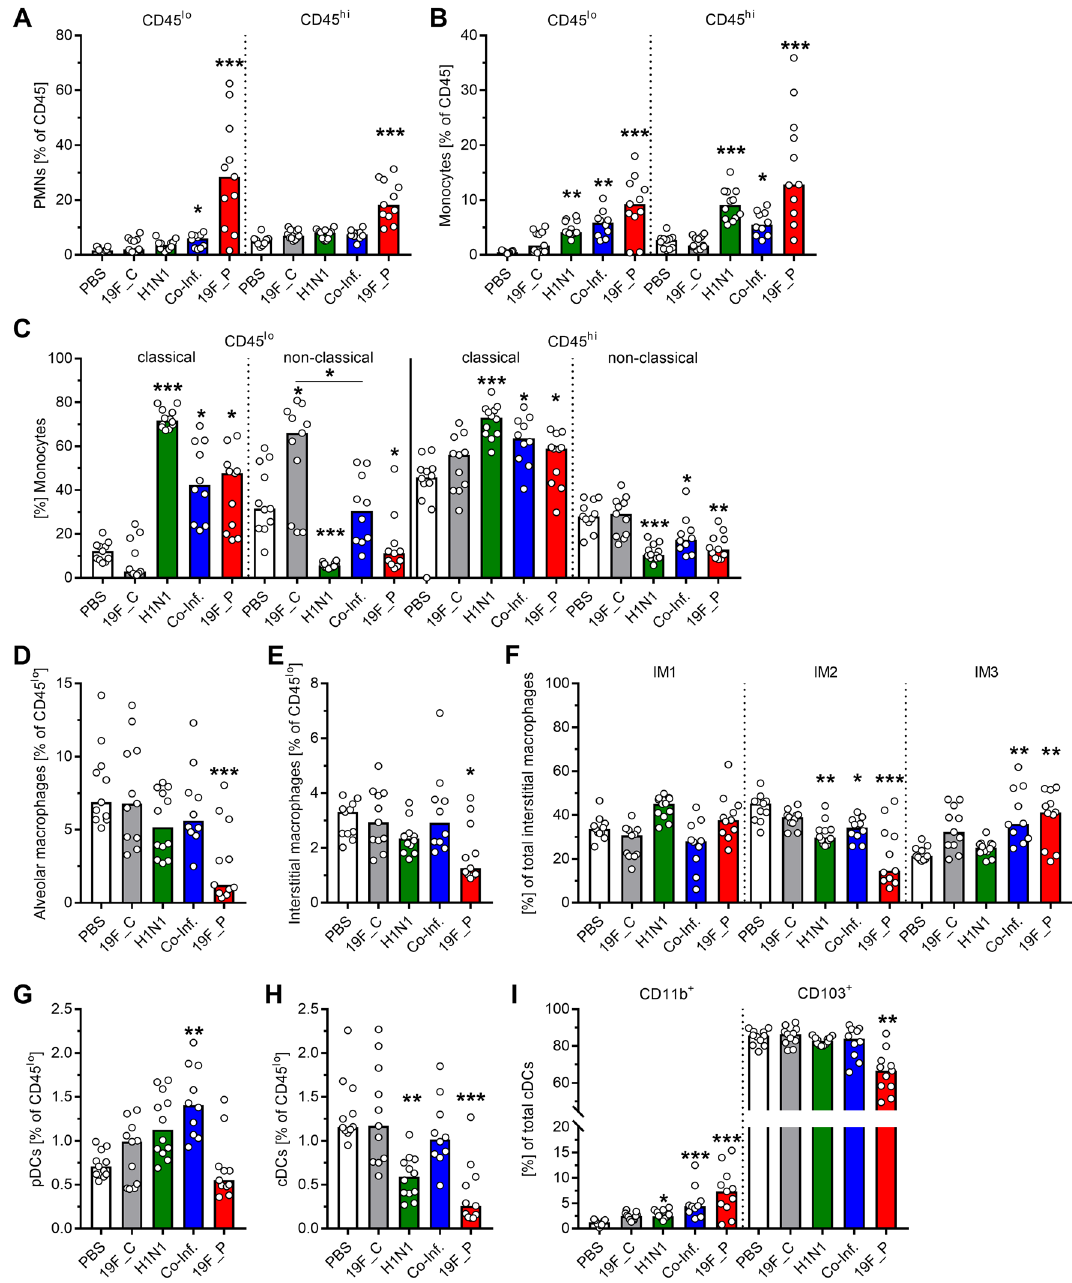
Figure 5. Innate immune cell composition of the lungs in response to mono- and co-infections. The infections were performed as displayed in ( A ). At day nine post infections, lungs were harvested, digested, and resulting single cell suspensions were analyzed via flow cytometry. CD45 lo cells were classified as cells from the alveolar/ interstitial compartment and CD45 hi cells as cells from the vascular compartment of the lung. Frequencies of ( A ) neutrophils (PMNs), ( B ) total monocytes and ( C ) monocyte subsets, ( D ) alveolar macrophages (AMs), ( E ) interstitial macrophages (IMs) and ( F ) IM subsets, ( G ) plasmacytoid dendritic cells (pDCs), ( H ) conventional DCs (cDCs), and ( I ) cDC subsets are displayed. Two independent experiments with six mice per group (total: n ≥ 10) were performed. Each dot represents one mice and bars denote median values. The level of significance between the PBS and all other groups was determined using Kruskal Wallis test with Dunn’s multiple comparison post-test (* p < 0.05; ** p < 0.01; *** p <